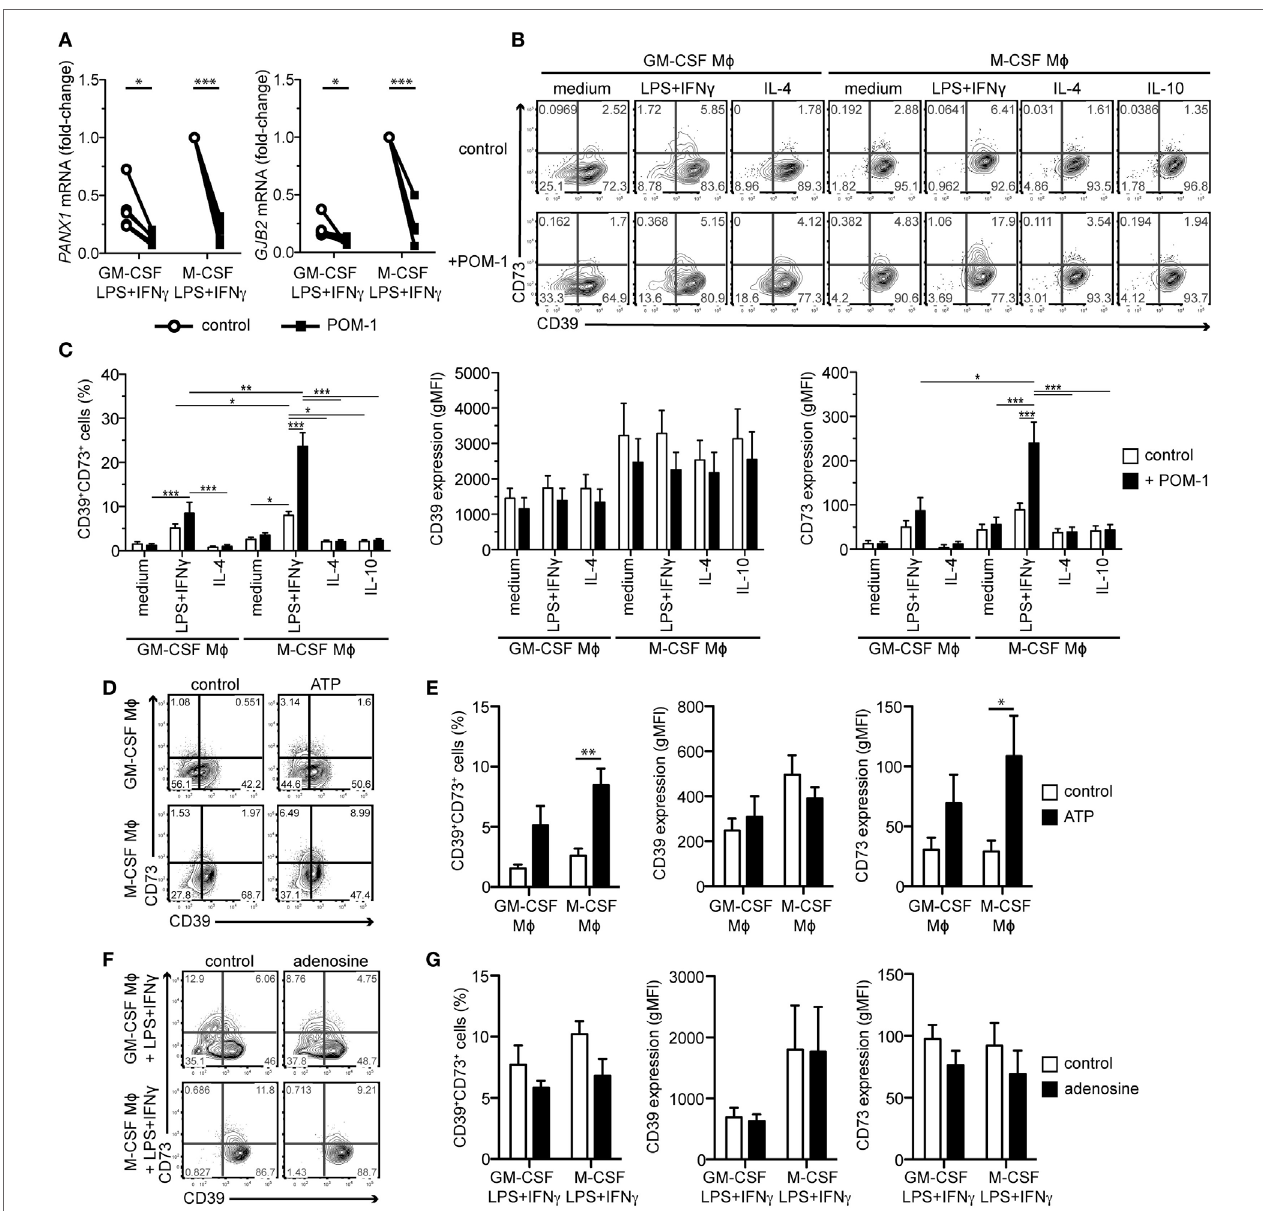
FigUre 4 | Effects of the CD39 inhibitor POM-1, extracellular ATP, and extracellular adenosine on expression of ATP release channels and adenosine-producing enzymes. (a) Macrophages (M ϕ s) of both lineages were activated for 2 days with LPS + IFN γ in the absence (control) or presence of 20 µM POM-1. Expression of the genes encoding ATP release channels PANX1 and GJB2 was then analyzed by qRT-PCR. To compare gene expression, the data were normalized to the mRNA levels in the M-CSF LPS + IFN γ -stimulated M ϕ s that were set to one. Data represent five different donors. (B–g) M ϕ s were differentiated and activated as indicated. POM-1, ATP, adenosine, or respective controls were added during the activation step. (B) The expression of CD39 and CD73 on the indicated M ϕ subtypes in the absence or presence of 20 µM POM-1 was analyzed by flow cytometry. (c) Quantification of the data shown in (B) ( n = 12). (D,e) Expression of CD39 and CD73 on GM-CSF or M-CSF-differentiated M ϕ s in the absence or presence of 100 µM ATP was analyzed by flow cytometry. One representative experiment (D) and statistics from four independent experiments (e) is given. (F,g) Flow cytometry analysis of CD39 and CD73 expression on the surface of LPS + IFN γ -stimulated GM-CSF- or M-CSF-differentiated M ϕ s in the absence or presence of 10 µM adenosine. One representative experiment (F) and statistics from four independent experiments (g) is given. Statistical significance was assessed by unpaired two-tailed t -test or one sample t -test for GM-CSF- or M-CSF-differentiated M ϕ s, respectively (a) or by two-way ANOVA with Bonferroni posttest (c,e,g) ; * p < 0.05, ** p < 0.01, *** p <